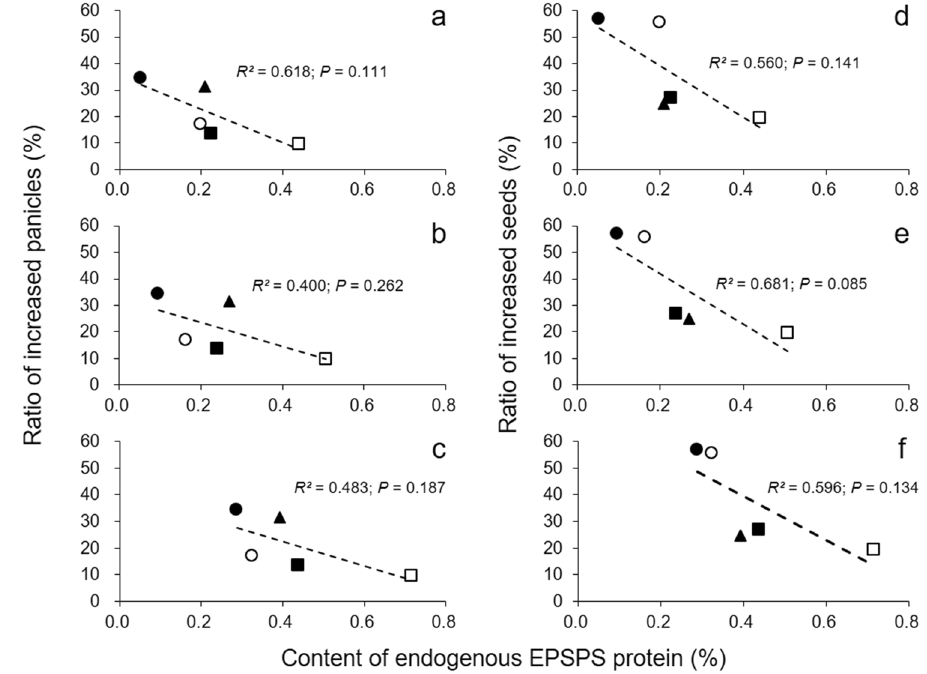
Figure 5. Correlation between the ratios of increased panicles ( a , b , and c ) or seeds ( d , e , and f ) and the content of endogenous EPSPS proteins in different transgene recipients (parents) at 60 (a and d), 100 ( b and e ), and 160 ( c and f ) days after seed germination. Solid diamonds: wild rice (WR1); empty diamonds: wild rice (WR2); empty circles: weedy rice (WRD1); solid circles: weedy rice (WRD2), and solid triangles: cultivated rice